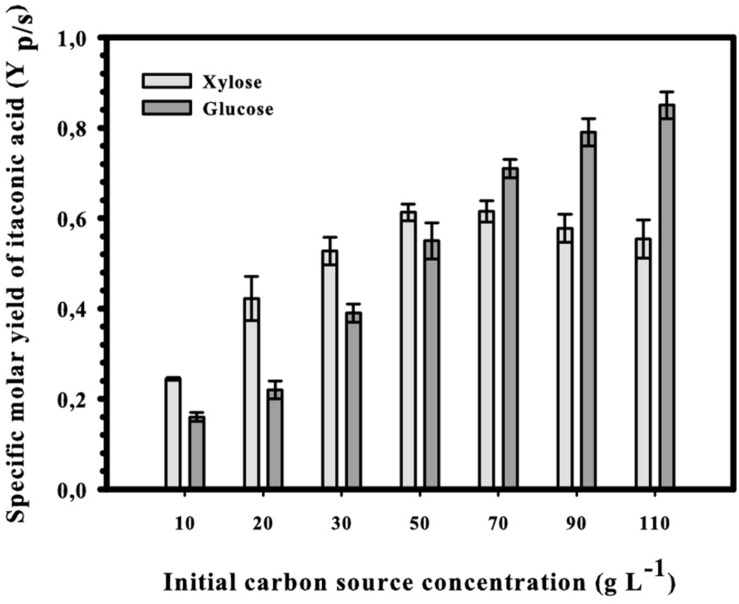
Specific molar yield of itaconic acid at different initial D-xylose concentrations in Mn2+ ion-limited shake-flask cultures of Aspergillus terreus NRRL 1960. Yields were calculated from the consumed D-xylose and maximal achieved IA concentrations.